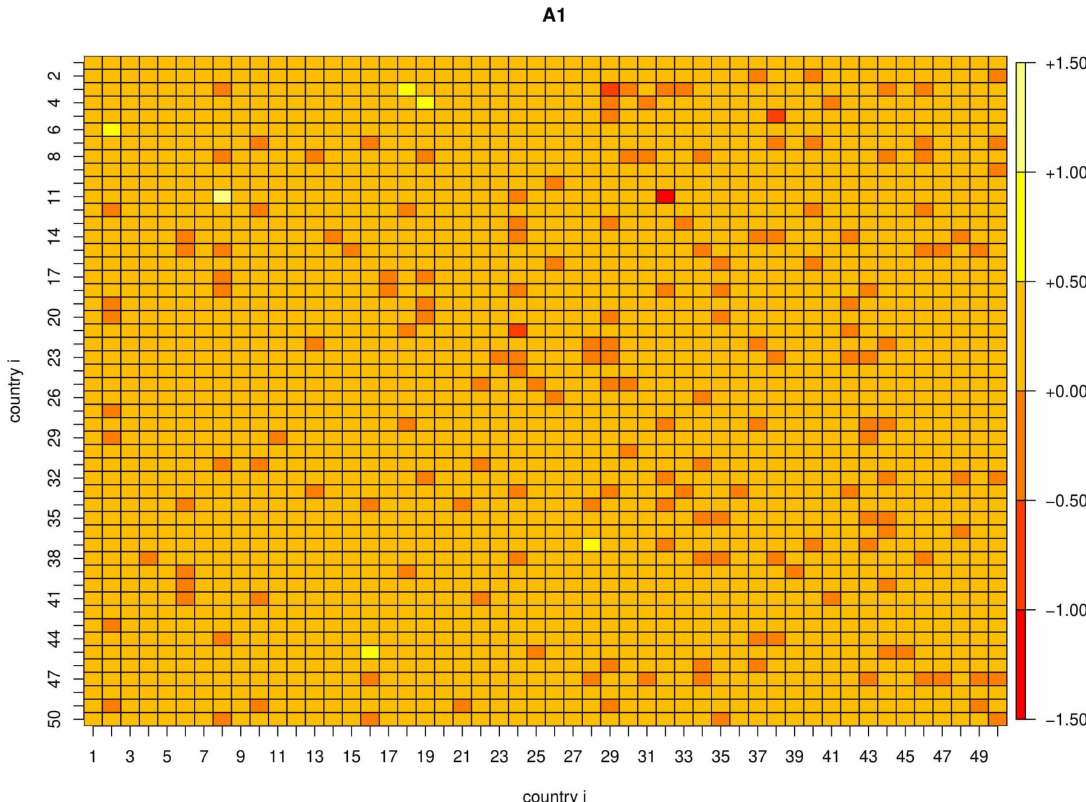
Figure 2. Estimated parameter matrix A 1